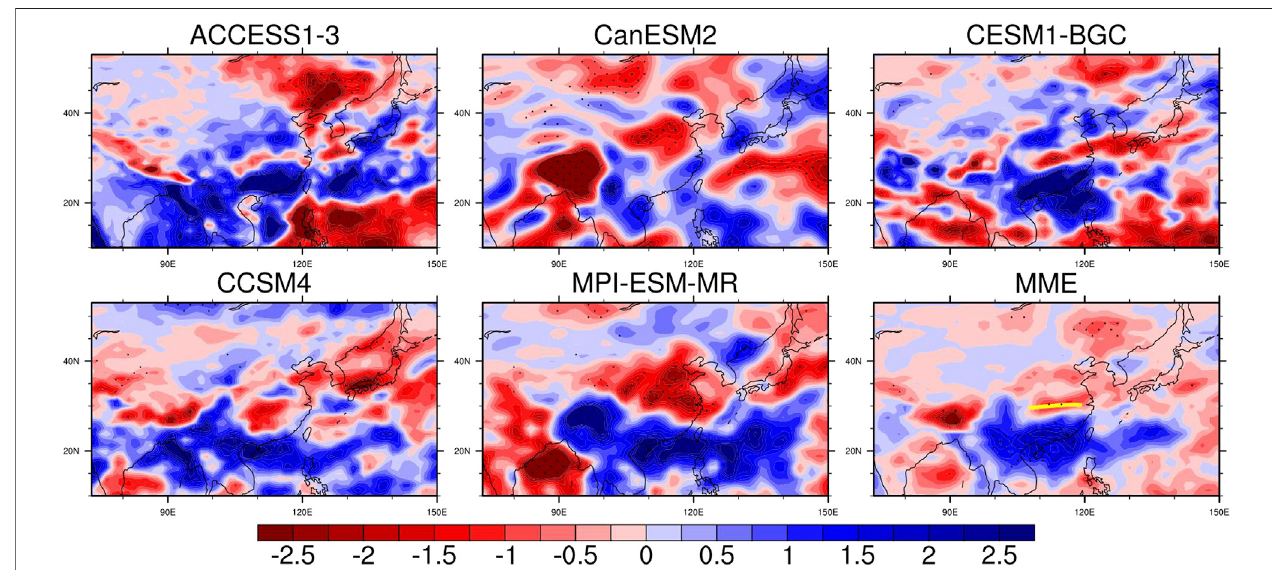
FIGURE 5 | The changes of the precipitation anomaly (mm/day) during strong EP events in the following summer between the RCP8.5 and historical experiments for CMIP5 (RCP8.5-historical, the yellow curve is constituted with the maximum precipitation anomaly during strong EP events in historical experiment).